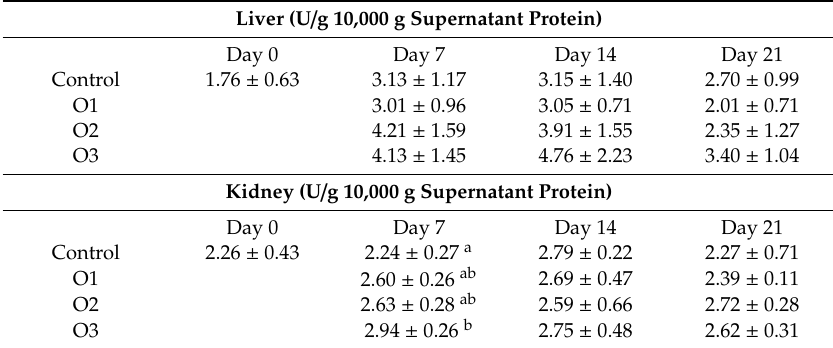
Table 6. E ff ect of Ochratoxin A treatment on glutathione peroxidase activity in liver and kidney homogenates (mean ± SD; n =